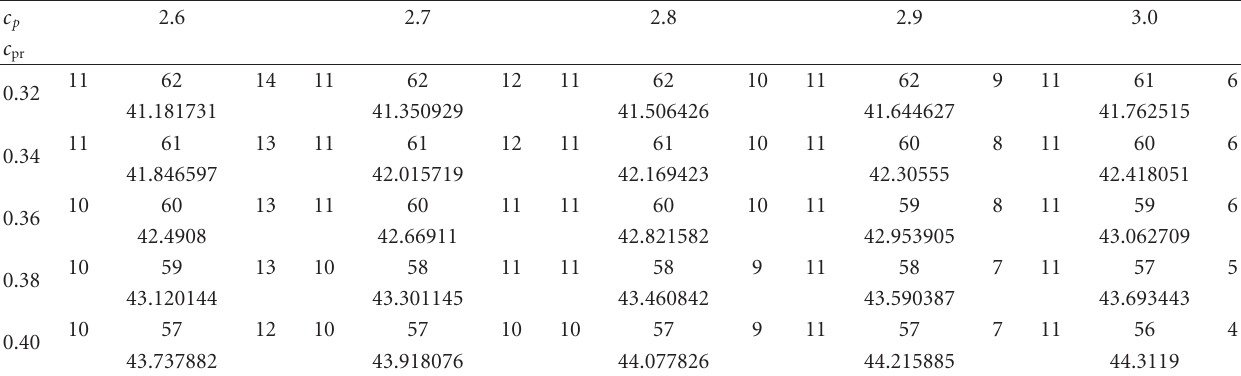
Table 20: Variation in Optimal values for di ff erent values of c p and c pr ( c s = 15, c h = 0 . 3, c sh =